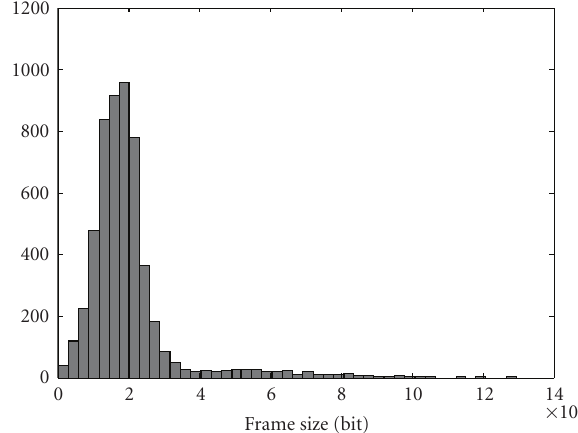
Figure 1: Histogram of video frame sizes.